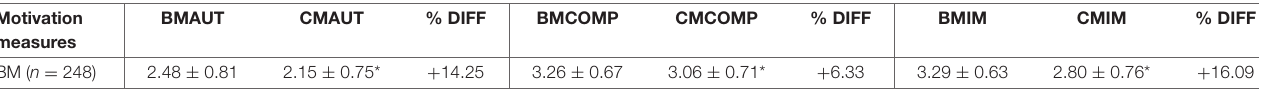
TABLE 2 | Acute Motivation (IMI) for the intervention group, BM, for sessions with Basketball combined with Mathematics (BM), and for Classroom-based Mathematics (CM). Motivation BMAUT measures